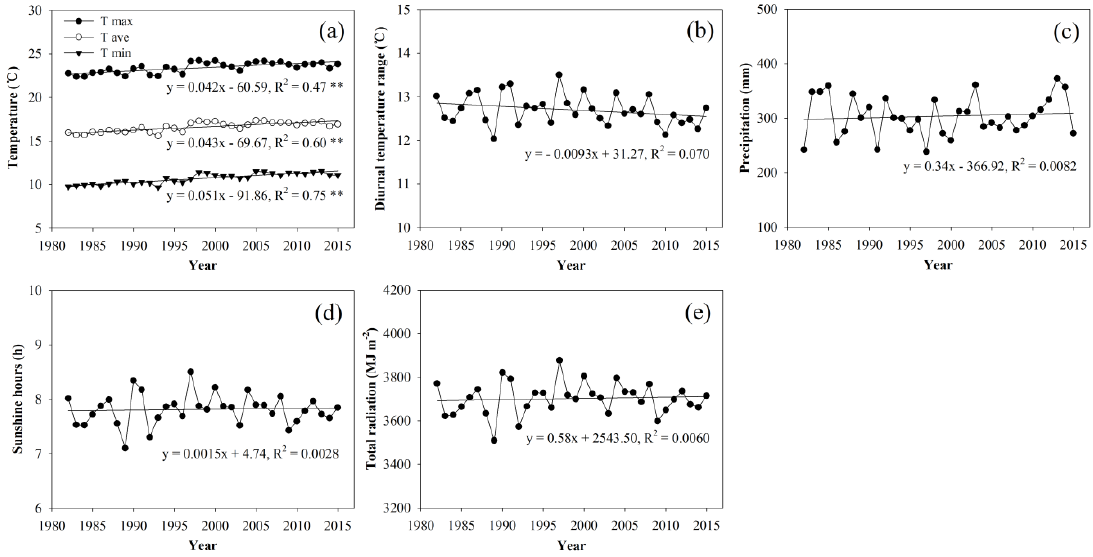
Figure 4. Changes in climatic variables during the potato growing seasons from 1982 to 2015 in northwest China: ( a ) temperature; ( b ) diurnal temperature range; ( c ) precipitation; ( d ) sunshine hours and ( e ) total radiation.